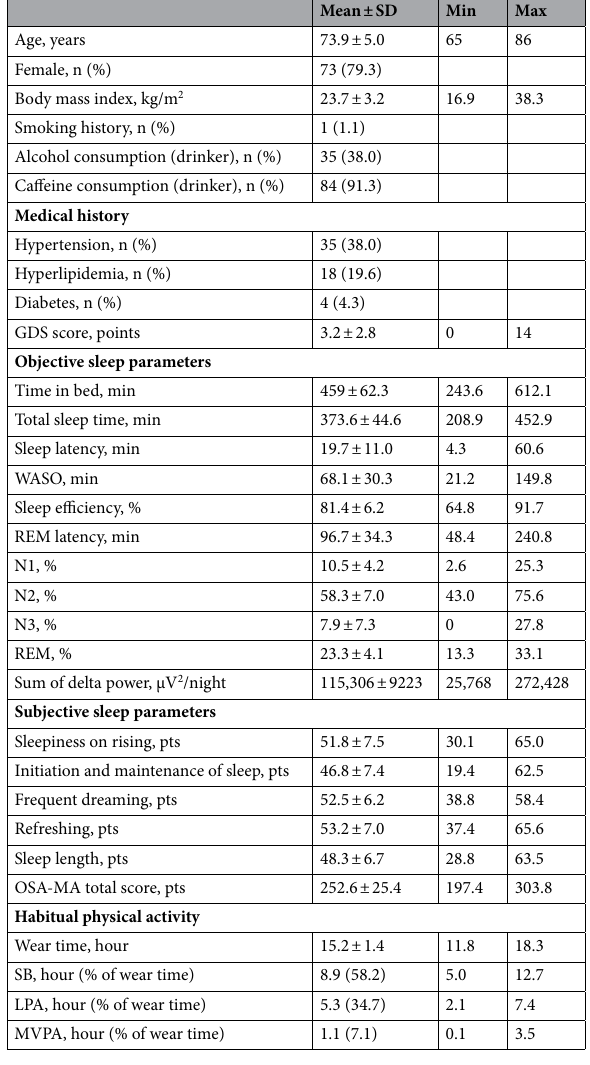
Table 1. Characteristics of participants. SD standard deviation, GDS Geriatric Depression Scale (Sheikh JI and Yesavage, 1986), WASO wake after sleep onset, N non-REM sleep stage, REM rapid eye movement,